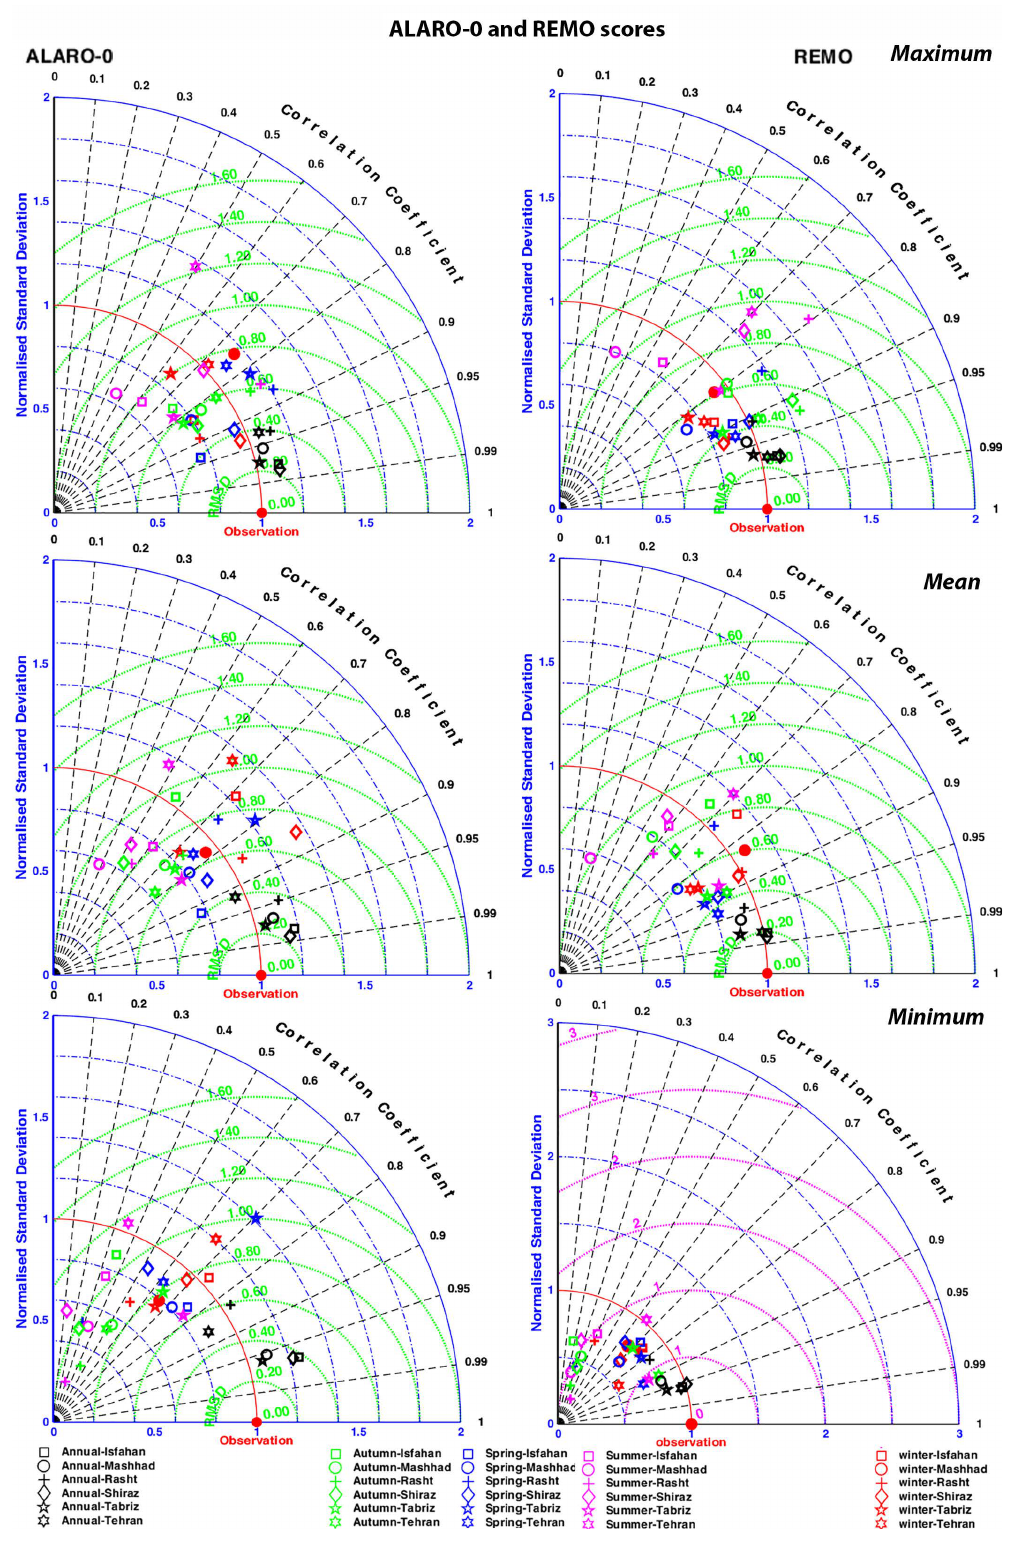
Figure 5. Normalised Taylor diagrams for annual and seasonal maximum ( a ), mean ( b ) and minimum ( c ) temperature comparing ALARO-0 and REMO scores for the studied stations during